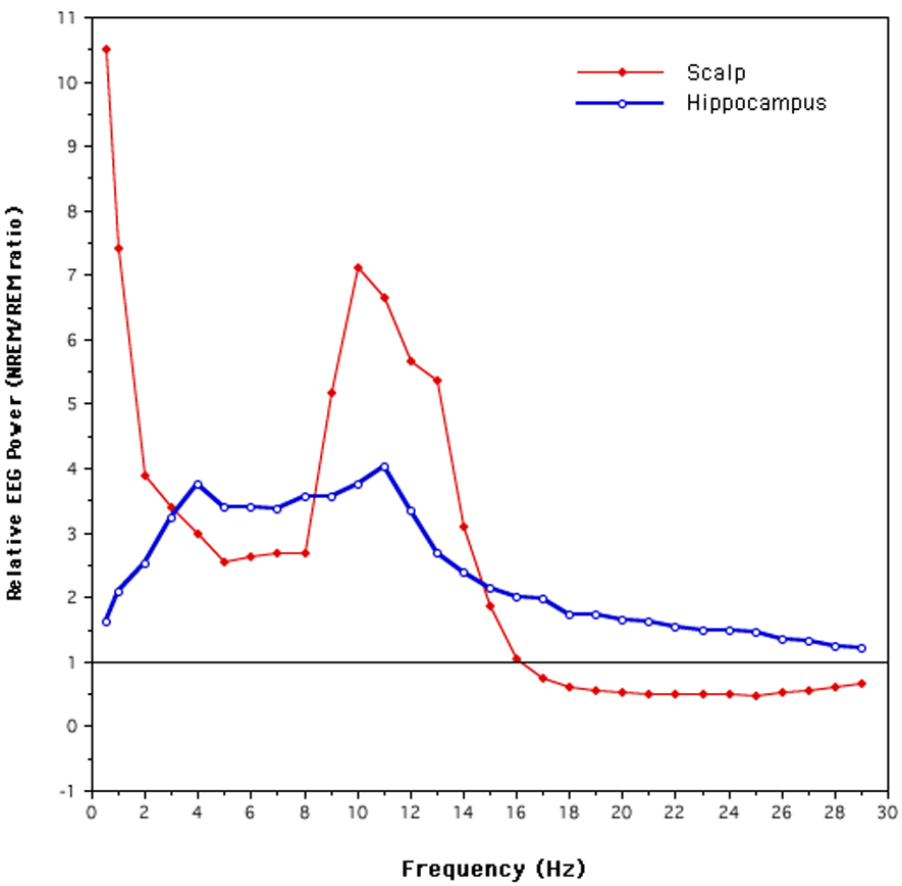
Figure 5. NREM/REM EEG power ratio in the entire (Hz by Hz) 0.5–30 Hz frequency range of the whole night, separately for scalp and hippocampal recordings. The horizontal line indicate the mean REM sleep EEG power (value=1). Mean values close to this line indicate that NREM and REM sleep power are equivalent in that frequency bin.